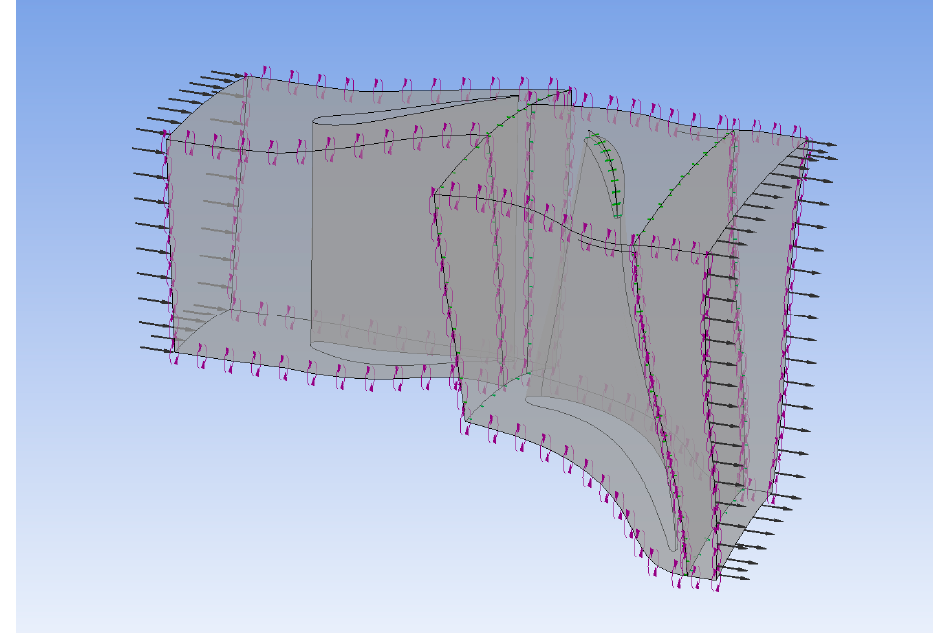
Figure 7. Overview of CFD setup using ANSYS CFX turbo mode.